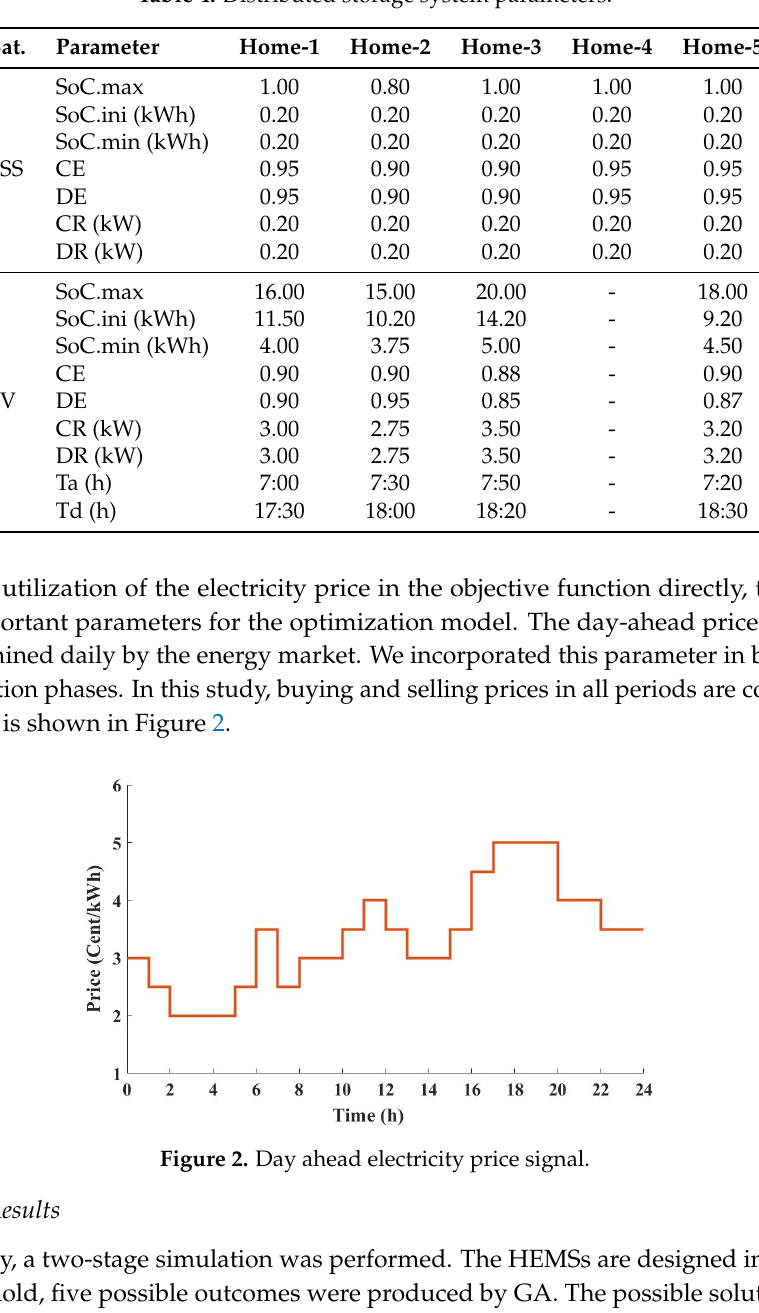
Table 4. Distributed storage system parameters.